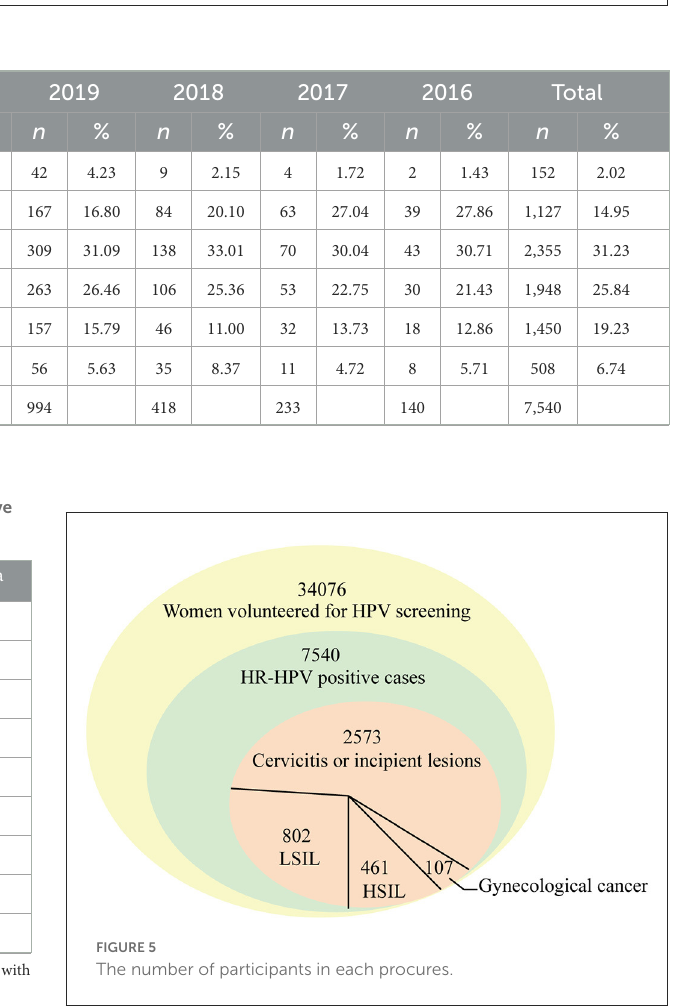
FIGURE4 Prevalence of HR-HPV in women under 40 years old (A) and Prevalence of seven HR-HPV genotypes in women aged 20-29 years old in different years (B) .